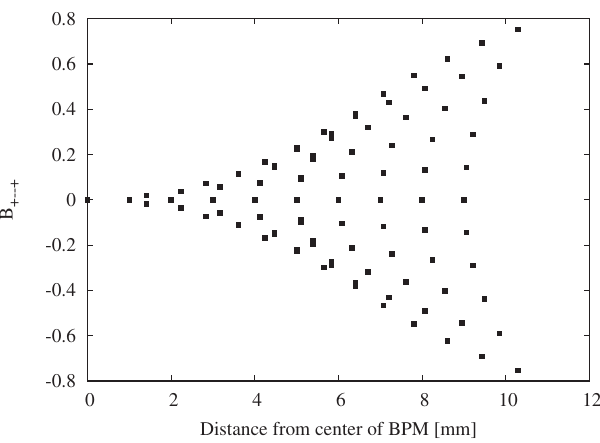
p ffiffiffiffiffiffiffiffiffiffiffiffiffiffiffiffi x 2 þ y 2 ) from the center of